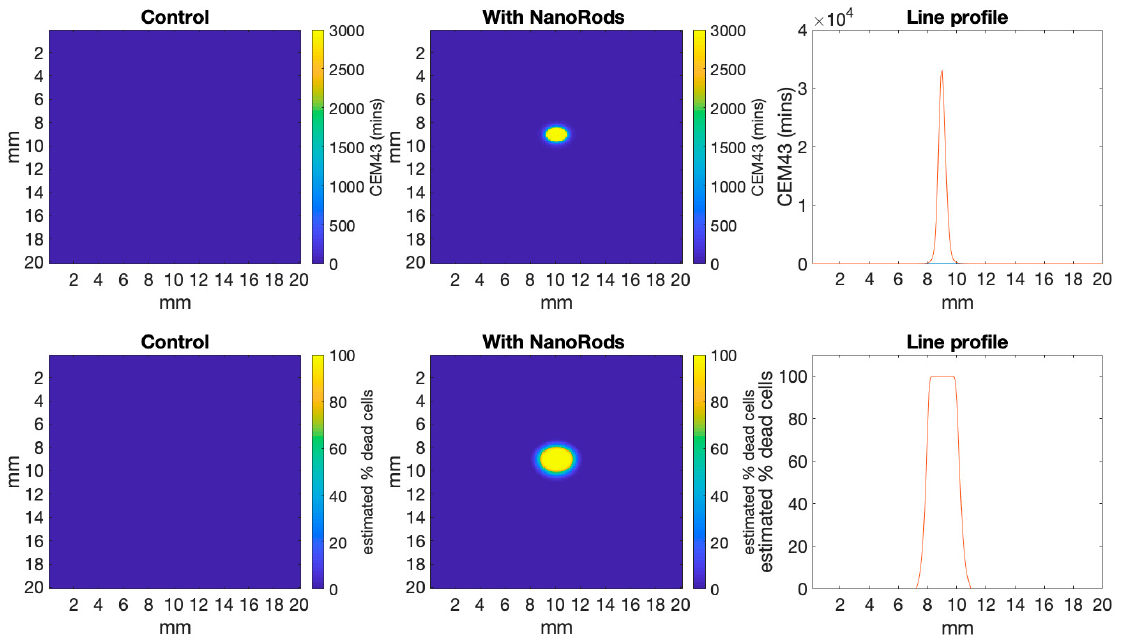
Figure 5. Shows the heat diffusion simulation at 10 min (600 s) converted to cumulative equivalent minutes at 43 ◦ C (CEM43) (Top Panel), and the estimated percentage cell death that is the result of the time spent at CEM43 (Bottom Panel). This shows that within the tumour region 100% of cells are likely to die due to the thermal dose they receive, with this likelihood dropping off steeply with distance from the tumour (more details in Figure 6).